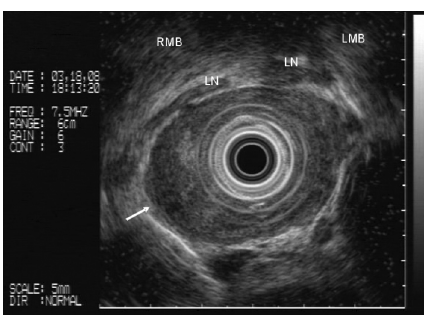
Figure 1 - Endoscopic ultrasound: absence of tracheobronchial invasion by neoplasia. LN (lymph node); RMB (right main bronchus); LMB (left main bronchus)